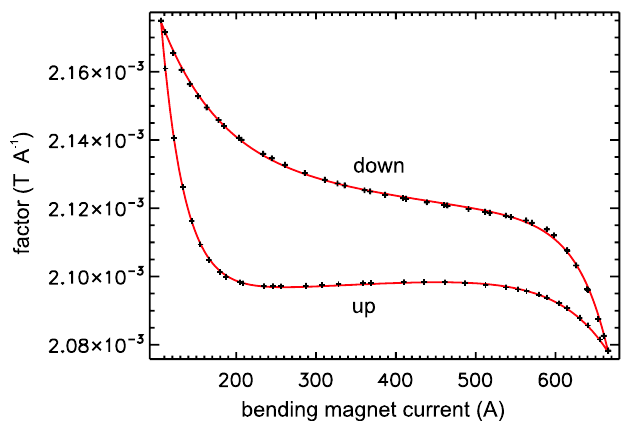
FIG. 13. (Color) A few electrons stored in the MLS. The beam lifetime has artificially been reduced by means of a scraper that is placed close to the electron beam.